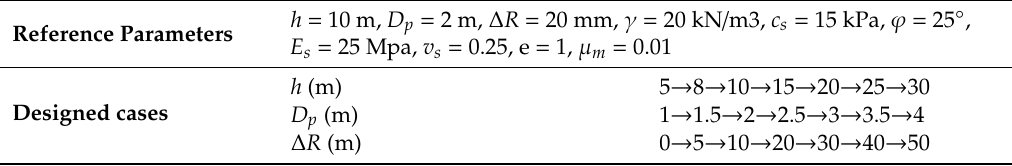
Table 8. The reference parameters and cases designed to study the influence of factors on friction resistance.